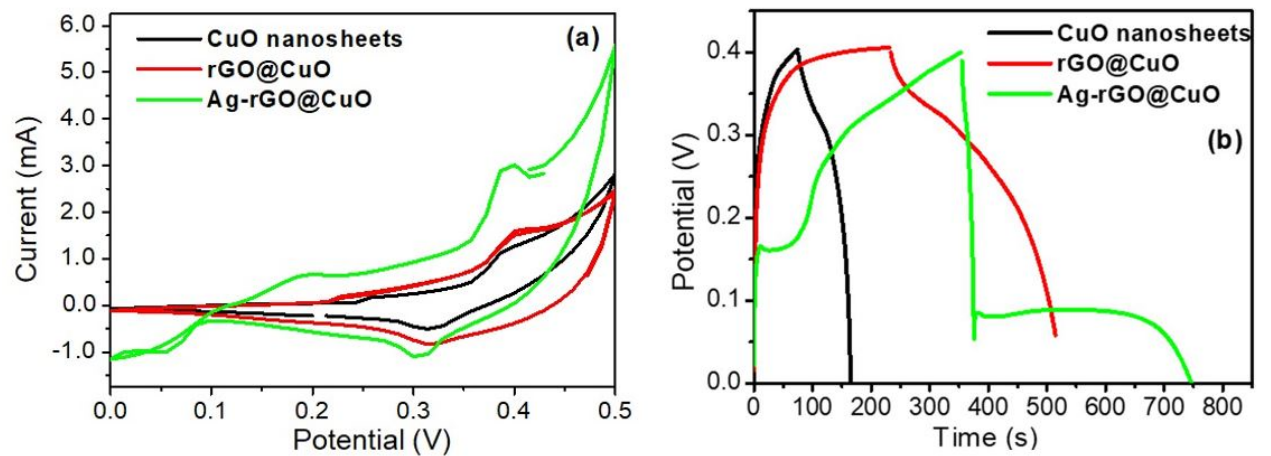
Figure 8. Comparative ( a ) cyclic voltammetry (CV) and ( b ) GCD plots of pure CuO nanosheets, rGO@CuO, and Ag-rGO@CuO.